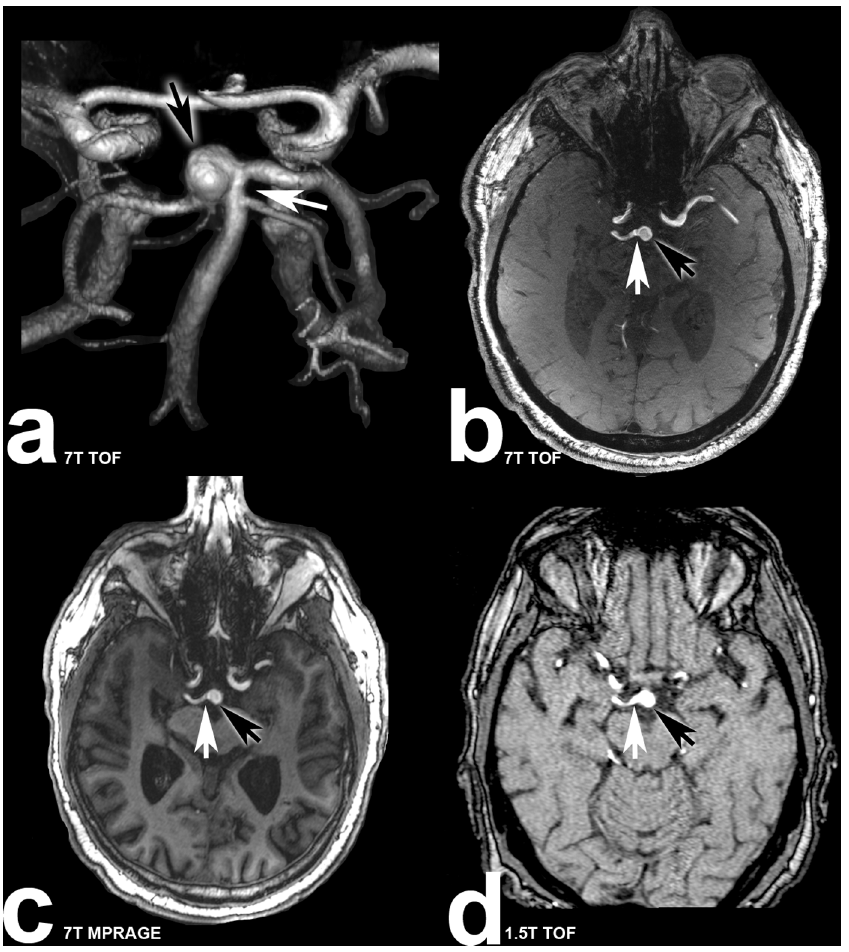
Figure 1. Seventy years old male patient (subject 5) suffering from basilar tip aneurysm. White arrows are marking the aneurysm neck, black arrows are marking the aneurysm dome. a: Volume rendering of the 7 Tesla TOF MRA demonstrating the three dimensional structure of the aneurysm; b: transverse plane of the 7 Tesla TOF MRA clearly depicting the aneurysm dome, neck and parent vessel; c: 7 Tesla MPRAGE sequence with excellent delineation of the aneurysm; d: 1.5 Tesla TOF MRA scan with minor irregularities of the parent vessel and aneurysm dome.